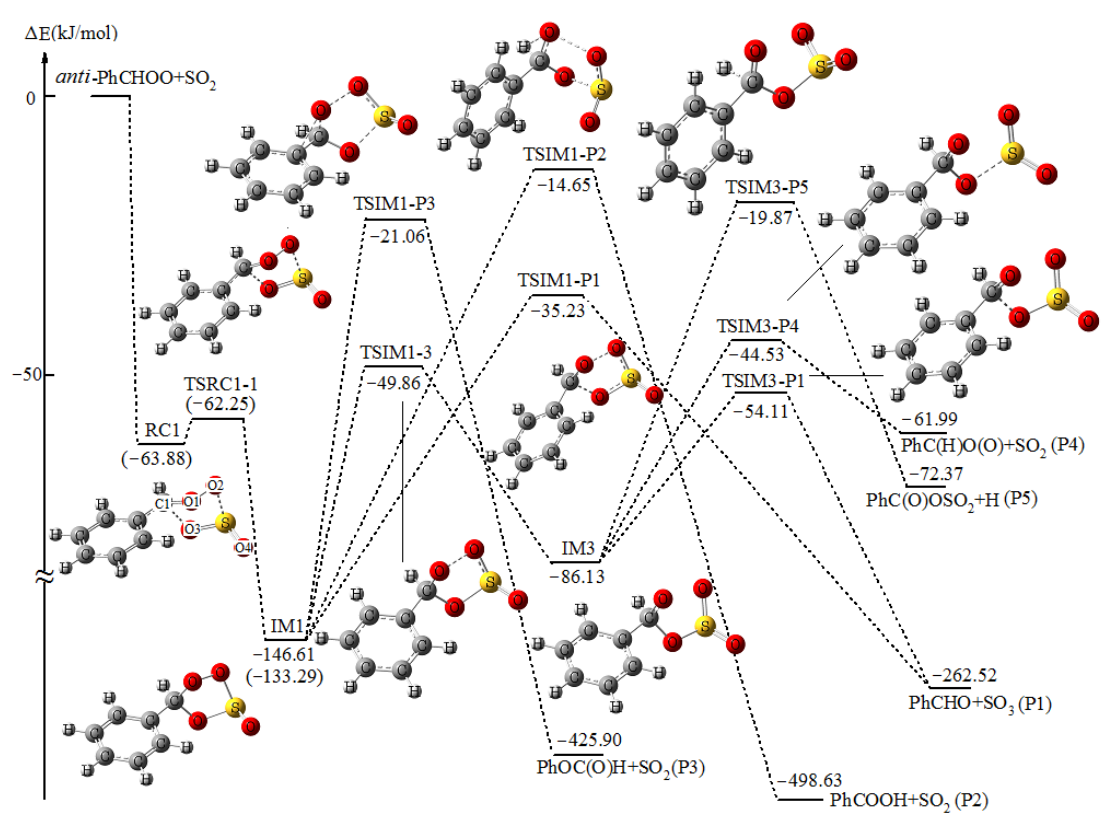
Figure 1. Potential energy profile for the formation and subsequent reaction pathways of endo PhCHOOS(O)O (IM1) in the reaction of anti -PhCHOO + SO 2 at the UCCSD(T) // UB3LYP level with zero-point vibrational energy (ZPE) corrections. The values in parentheses are derived from UCCSD(T) // UBH&HLYP level with ZPE corrections.